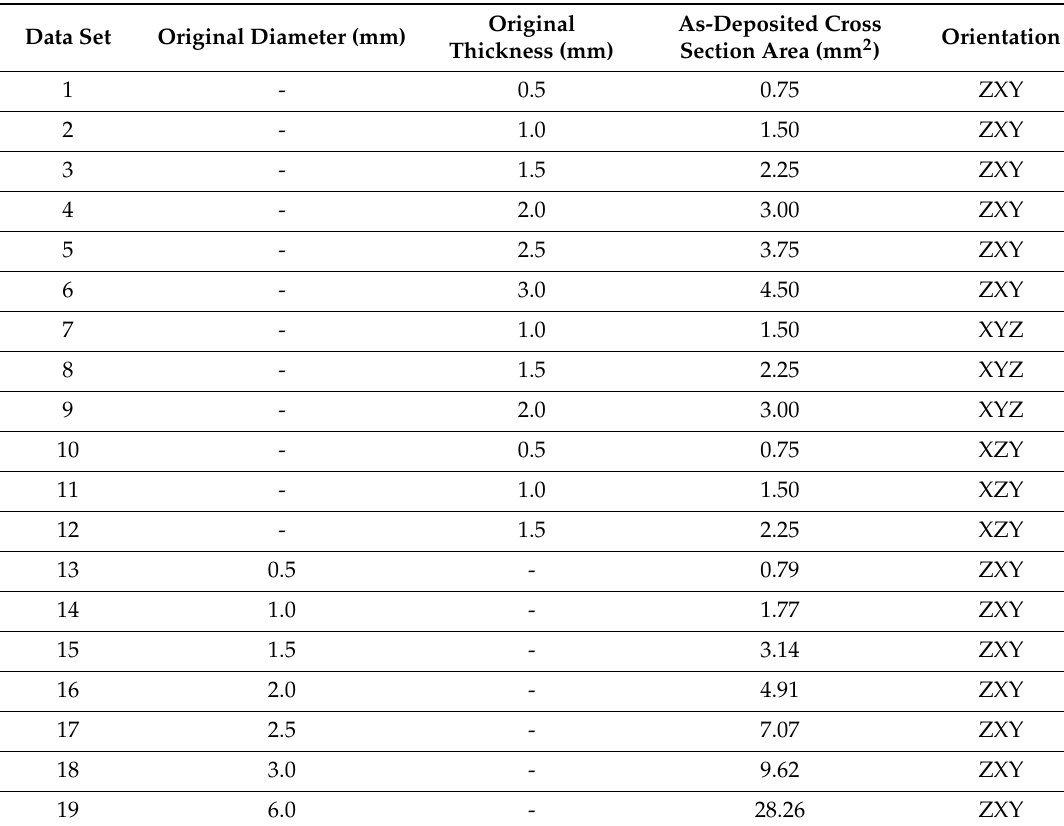
Table 3. Specimen data set designation and build orientations for EBM